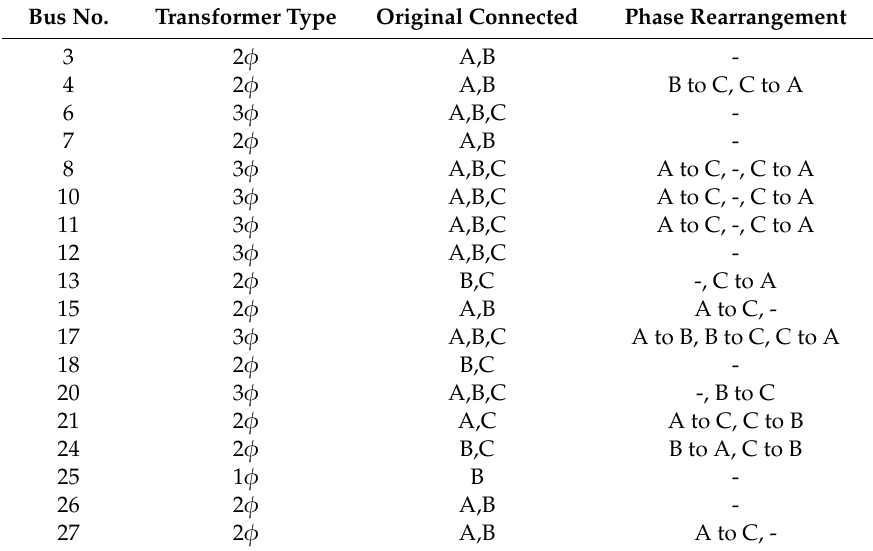
Table 3. The optimal phase connected to distribution transformers.